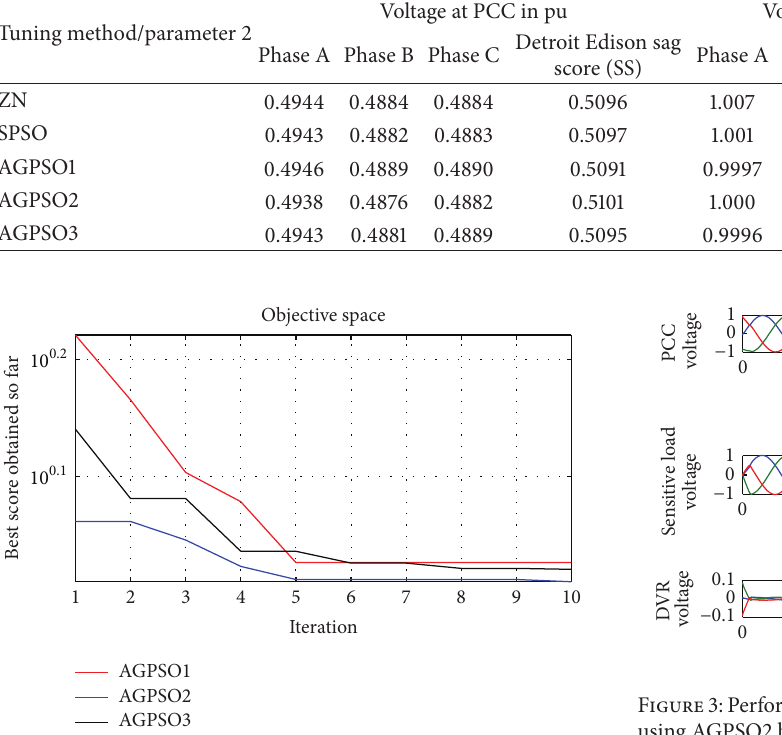
Figure 2: Convergence plot of various AGPSO algorithms.